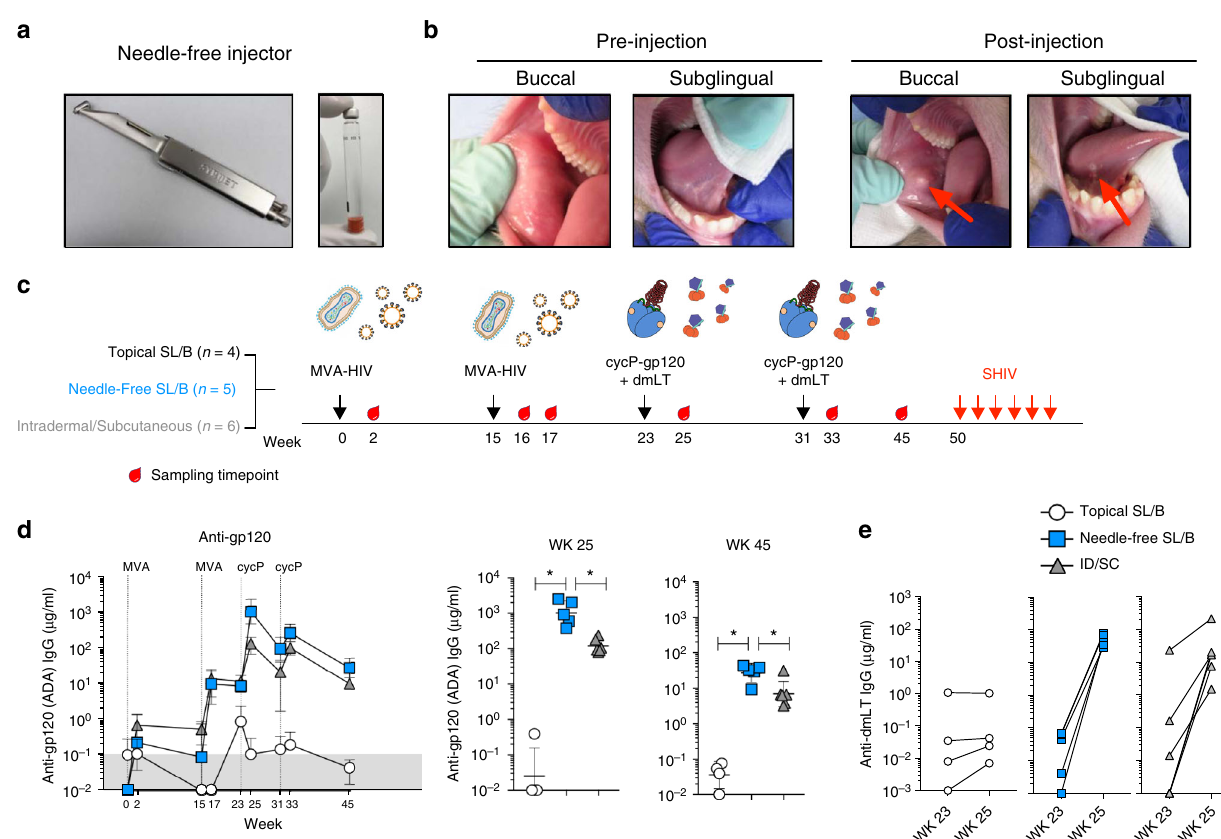
Fig. 2 SL/B immunization with a needle-free injector induces strong systemic antibody responses. a Syrijet, the needle-free injector used to deliver immunizations to the sublingual and buccal tissue. Sterile water cartridges were modi fi ed to contain immunogens. b Sublingual and buccal tissue of a rhesus macaque before and fi ve minutes after 100 μ l PBS injection via Syrijet. c Study design. Rhesus macaques ( n = 15) were immunized twice with MVA- HIV (1 × 10 8 pfu) and boosted twice with recombinant trimeric gp120 (cycP-gp120) (100 μ g) with the mucosal adjuvant dmLT. Animals were immunized via topical application to the sublingual and buccal (SL/B) tissue ( n = 4), needle-free injection to the SL/B tissue ( n = 5), or intradermally (with MVA-HIV) and subcutaneously (with cycP-gp120 + dmLT) ( n = 6). MVA-HIV and cycP-gp120 doses were split between the buccal and sublingual tissue (SL/B) or the left and right thigh (ID/SC). 19 weeks following the second cycP-gp120 immunization, animals were challenged intra-rectally with low dose pathogenic SHIV-SF162P3 weekly for up to six weeks. Cartoons depict MVA-HIV and virus-like particles, cycP-gp120, and dmLT. d Kinetics of anti-gp120 (ADA) serum IgG in vaccine groups (geomean ± SD) and for individual animals (line, geomean ± SD) at the peak time point (wk 25) and pre-challenge time point (wk 45) (*, p < 0.05; Mann – Whitney test). Dotted lines denote week of indicated immunization. e Anti-dmLT serum IgG response in animals before (wk 25) and two weeks post (wk 45) immunization with cycP-gp120 + dmLT. d , e White circle, topical SL/B ( n = 4); blue square, needle-free SL/B ( n = 5); gray triangle, ID/SC ( n = (Fig. 2a). First, we injected a rhesus macaque with 100 μ l of sterile PBS and visualized the injection site before and after injection (Fig. 2b). The Syrijet injected effectively into both the sublingual and buccal tissue with minimal damage and bleeding, and no additional swelling or damage was reported in the following days post injection. To evaluate the SL/B route of oral vaccination, we immunized female rhesus macaques orally via either topical application to the SL/B tissue ( n = 4), needle-free injection to the SL/B tissue ( n = 5), or the conventional intradermal and subcutaneous route (ID/ SC) ( n = 6). Macaques were immunized twice with 1 × 10 8 pfu (plaque-forming units) of MVA-HIV expressing HIV-1 clade B gag, pol, env (strain ADA) followed by two boosts with 100 μ g of trimeric clade B cycP-gp120 immunogen (strain JRFL) along with the mucosal adjuvant dmLT (Fig. 2c) 13,28 . Doses were split in half between the sublingual and buccal tissue or the left and right thigh of ID/SC immunization.